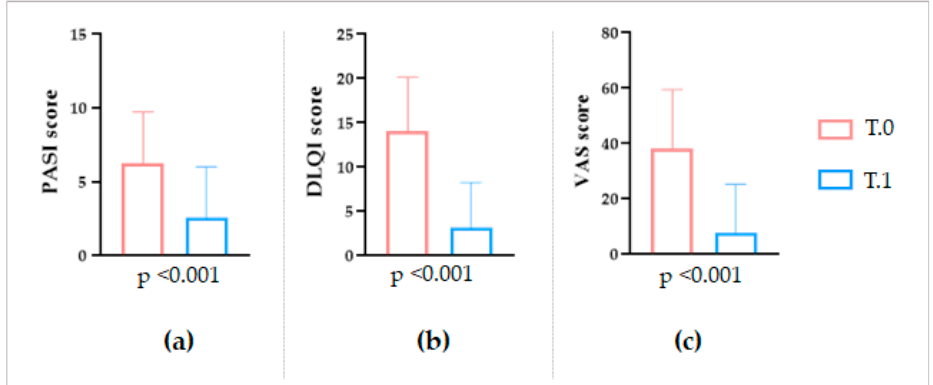
Figure 2. Statistical comparison between the ( a ) PASI, ( b ) DLQI, and ( c ) itch VAS scores registered before and after the LimpiAL treatment (Wilcoxon test, p ≤ 0.05).